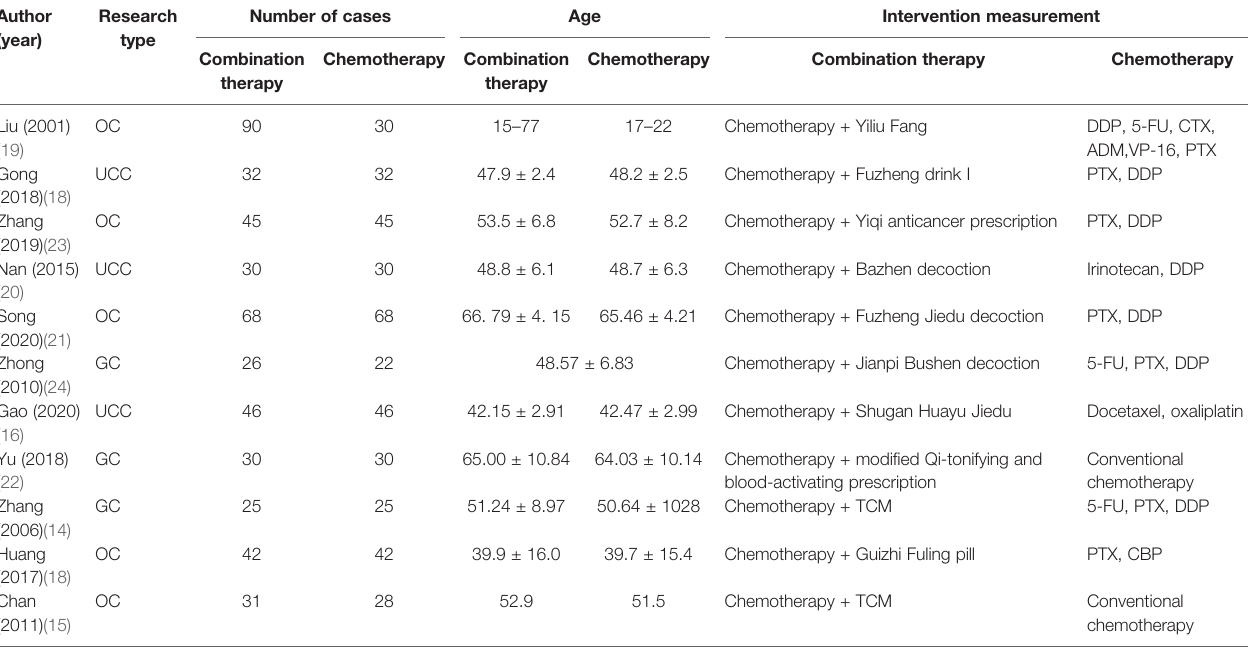
TABLE 1 | Characteristics of studies included in this